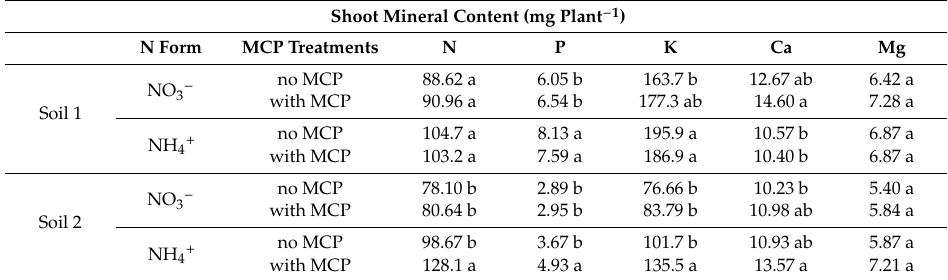
Table 4. Shoot accumulation of mineral nutrients in maize plants (cv. Jessy) on two low P soils. as a ff ected by MCP inoculation. Soil 1 (sandy-loam, pH 6.1, P CAL 7 mg kg − 1 soil) and Soil 2 (clay-loam, pH 5.9, P CAL 20 mg kg − 1 soil) receiving N fertilization in in form of Ca-nitrate (NO 3 − ) or